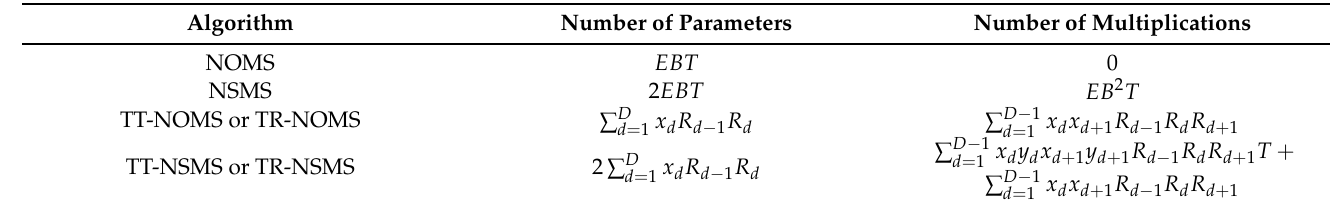
Figure 12. BER performance of TR-NOMS algorithms for LDPC(576,432) code with different rank. Table 3. Comparison of parameters and multiplication in NOMS [22], NSMS, TT-NOMS, TT-NSMS, TR-NOMS and TT-NSMS